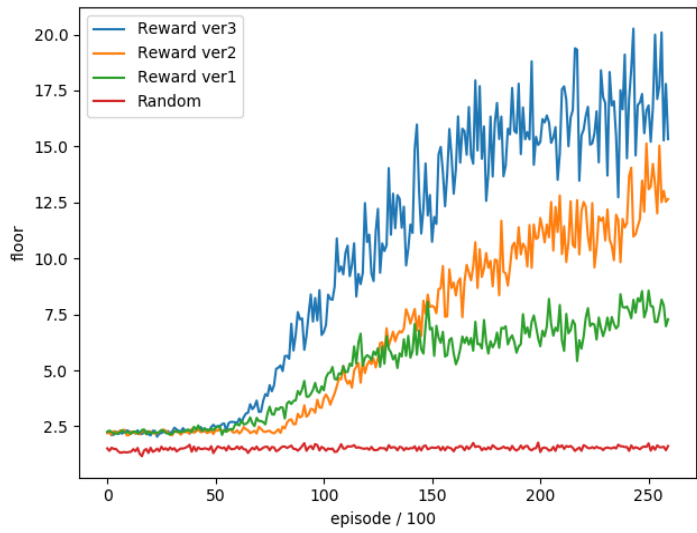
Figure 17. The training trend of the three versions of reward